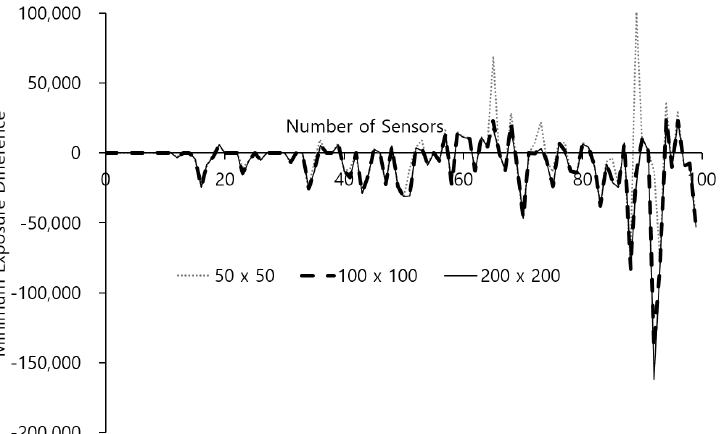
Figure 5. Minimum exposure difference from the minimum exposure value from the Voronoi Diagram (y) vs. number of deployed sensors following Figure 4. (x) in 100 × 100 area. Dotted line; 50 × 50 grids; broken line; 100 × 100 grids; solid line; 200 × 200